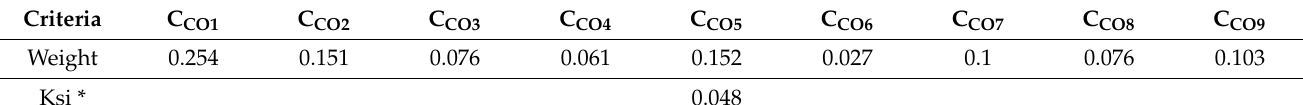
Table 4. Weight of criteria and inconsistency rate (Ksi *).